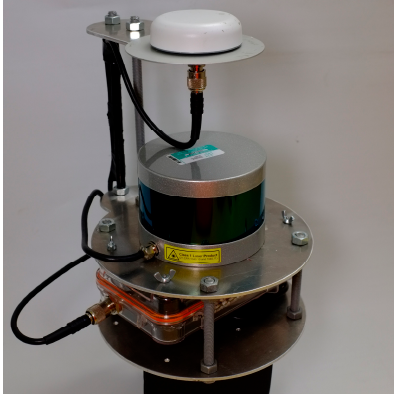
Figure 1. The complete measurement unit with global navigation satellite system (GNSS) antenna, Velodyne VLP16 laser scanner, and the Applanix APX-15 UAV sensor with an inertial measurement unit (IMU) at the bottom. The instrumentation was mounted and carried on a backpack during data capture in the field.